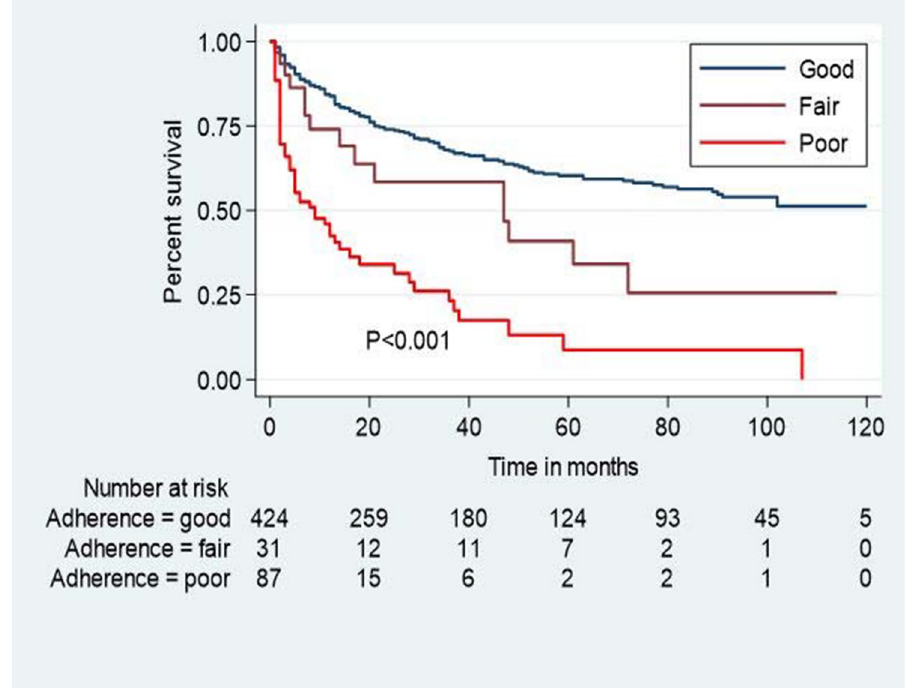
Figure 2. Kaplan–Meier survival estimates among HIV patients in Bichena health center, Amhara, North West, Ethiopia, January 1, 2008–December 30, 2017 by ART drug adherence level.